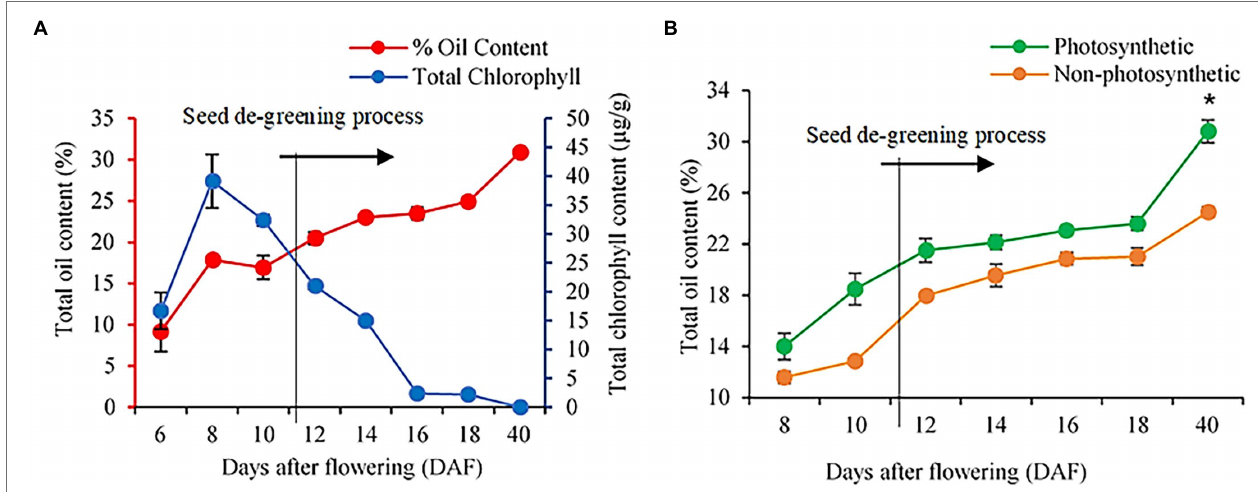
FIGURE 2 | Analysis of seed oil and chlorophyll content in WT and Atchlsyn1-1 mutant during development. (A) Biochemical estimation of total FAs and chlorophyll content in WT. Oil content is on the left or the primary Y-axis and chlorophyll content is on the right or secondary Y-axis. (B) The seed oil content of seeds from photosynthetic, green seeds (red), and non-photosynthetic, yellow (non-red) seeds. Blue lines indicate WT seed chlorophyll content. The Red line indicates WT seed oil content. The green line indicates photosynthetic, green/(red) seed oil content. The orange line indicates non-photosynthetic, yellow/(non-red) seed oil content. Values are means ±SD ( n = 3 biological replicates). Statistical significance was analyzed using the two-sided Student’s t -test. The asterisk indicates a significant difference ( * p <